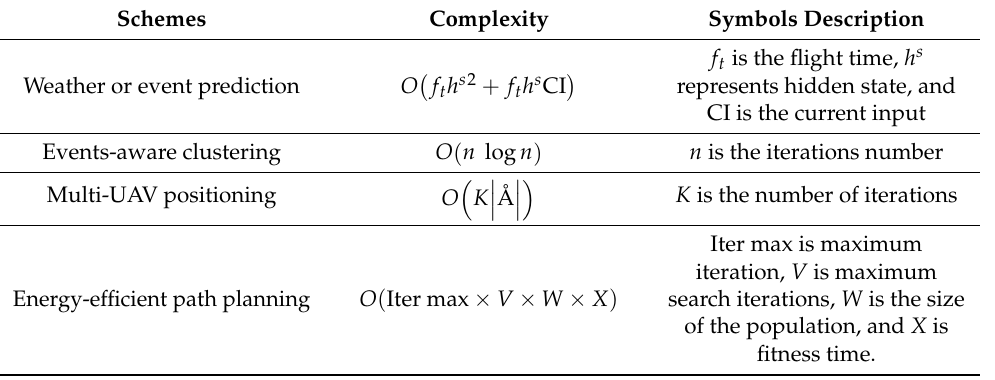
Table 8. Time complexity